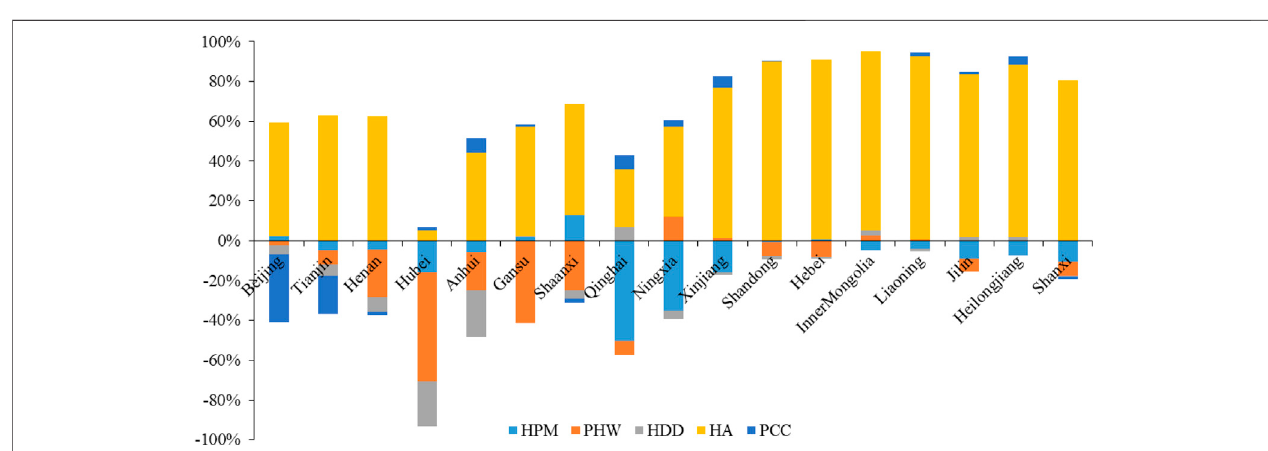
Frontiers in Energy Research |